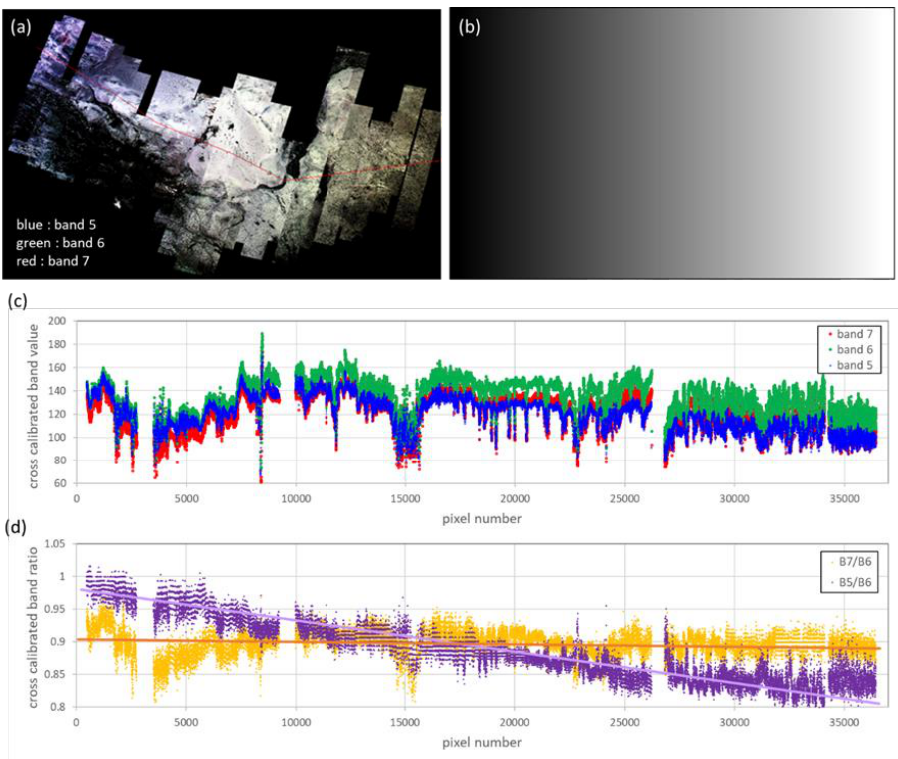
Figure A2. ( a ) Cross-calibrated ASTER color composite of SWIR Bands R:7 G:6 B:5. A transect from which pixel values were extracted is shown by a red line. ( b ) A linear ramp model. ( c ) Pixel values of cross-calibrated Bands 5 (blue), 6 (green) and 7 (red) for the transect shown in ( a ). ( d ) The same data as in ( b ) but with Bands 5 and 7 each normalized with respect to Band 6. Note the linear trend in the B 5 /B 6 ratio data (mauve line), which was used for the design of the model.